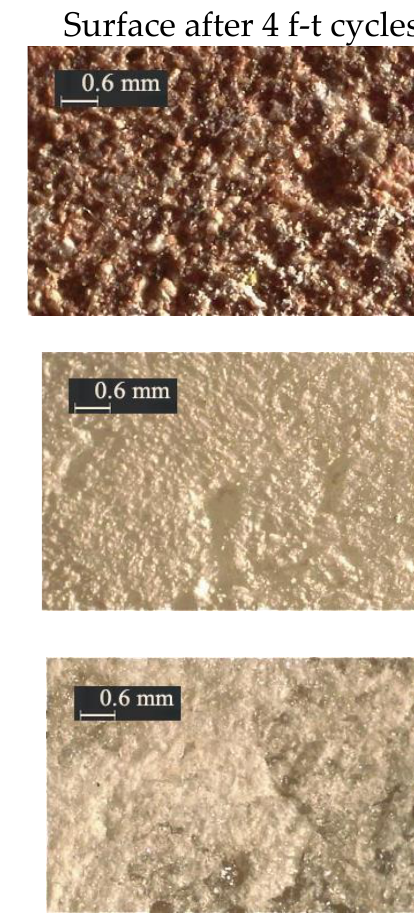
Figure 8. Experimental setups for ( a ) transmission and ( b ) reflection IRT measurements.